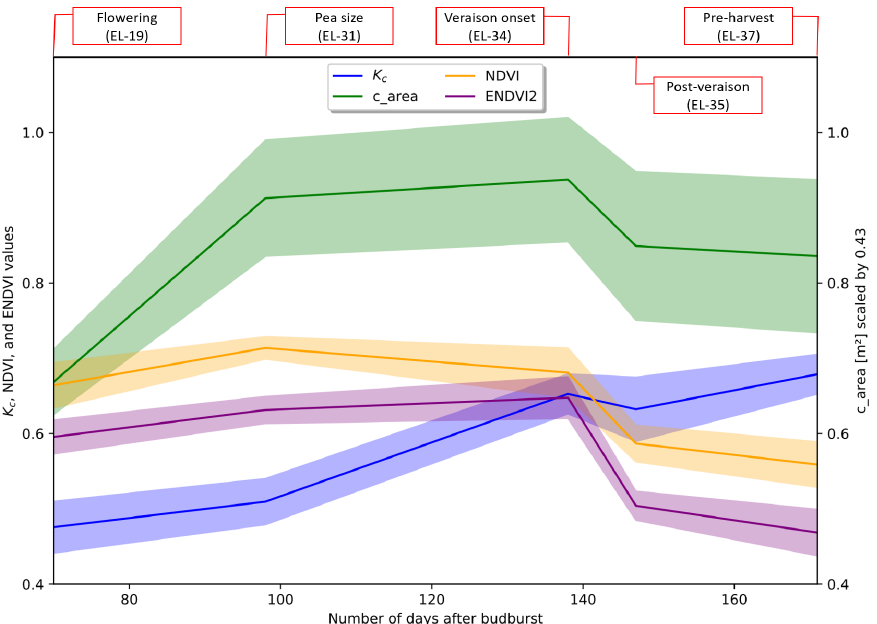
Figure 6. Seasonal evolution of the k c along with the highly correlated and statistically significant spectral features, represented in the primary y-axis and canopy area (c_area) represented in the second y-axis. The shaded band on the seasonal evolution plot represents the ± 1 σ around the mean.